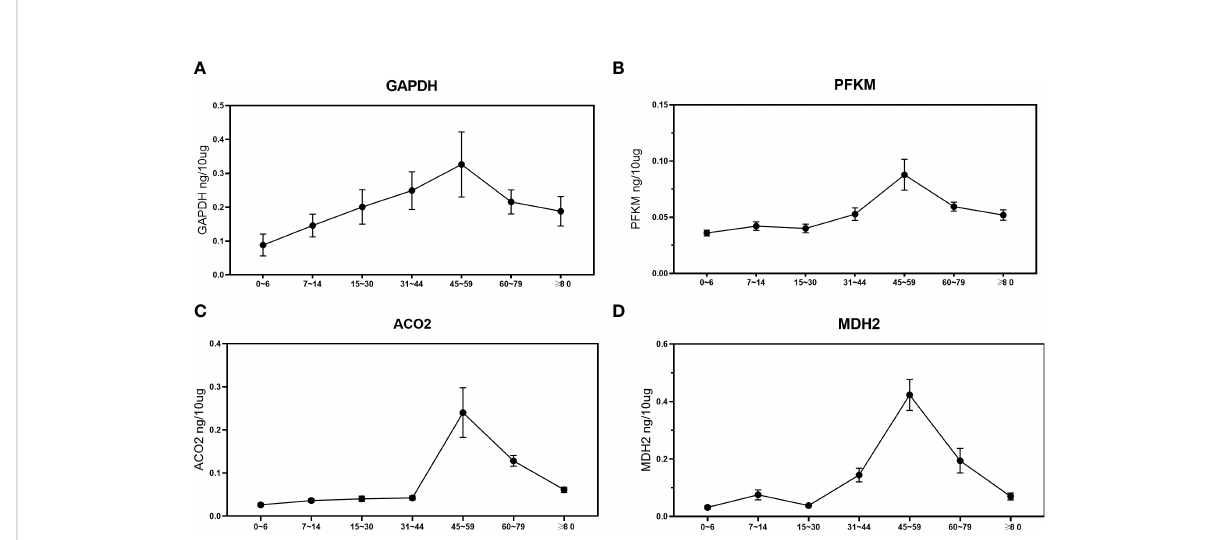
FIGURE 3 Analysis of the expression changes of four proteins in urinary exosomes of healthy people of different ages. Divided into 7 groups, 20 in each group, a total of 140 samples. Figure shows the concentration changes of GAPDH (A) , PFKM (B) , ACO2 (C) and MDH2 (D) in order. The abscissa represents different age groups, and the ordinate represents the expression of each protein measured by ELISA. The unit is ng/10 m g, which represents the target protein content per 10 m g total